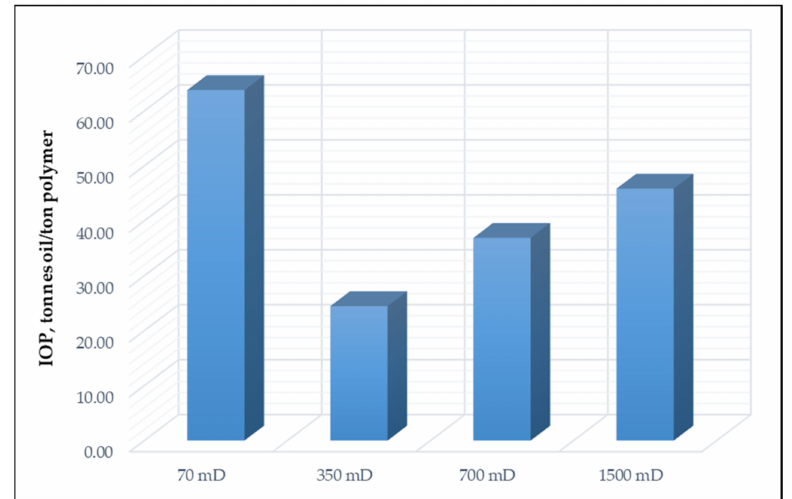
Figure 17. The specific effect on tons of used